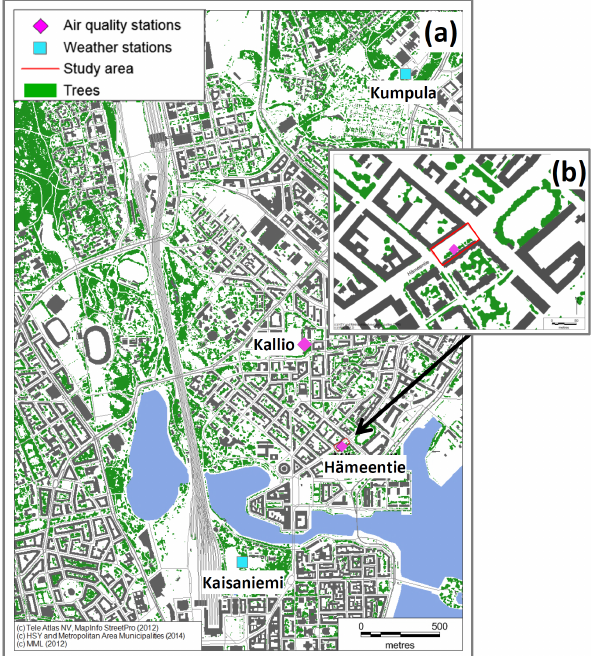
Figure 1. (a) The locations of the studied street segment (red rect- angle) at Hämeentie, kerbside (Hämeentie) and urban background (Kallio) air quality stations (pink diamond), as well as weather sta- tions (Kumpula and Kaisaniemi) (blue square) in central Helsinki. Trees have been marked with green circles. (b) Close-up view show- ing building blocks (marked with grey) and trees in the vicinity of the studied street segment.